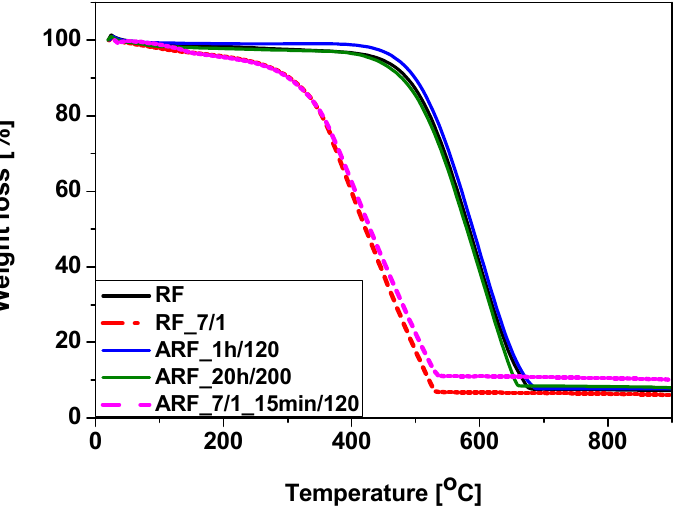
Figure 3. Thermogravimetric curves of the tested samples.